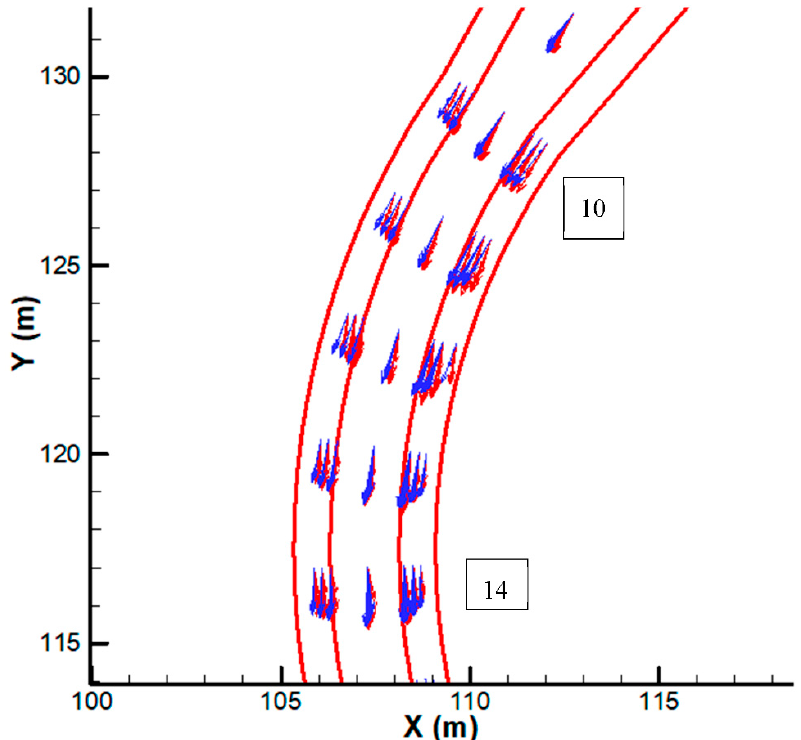
Figure A10. Plan-view comparison of simulated (blue) and measured (red) velocity vectors for the downstream portion of the upstream channel curve and straight transition reach.